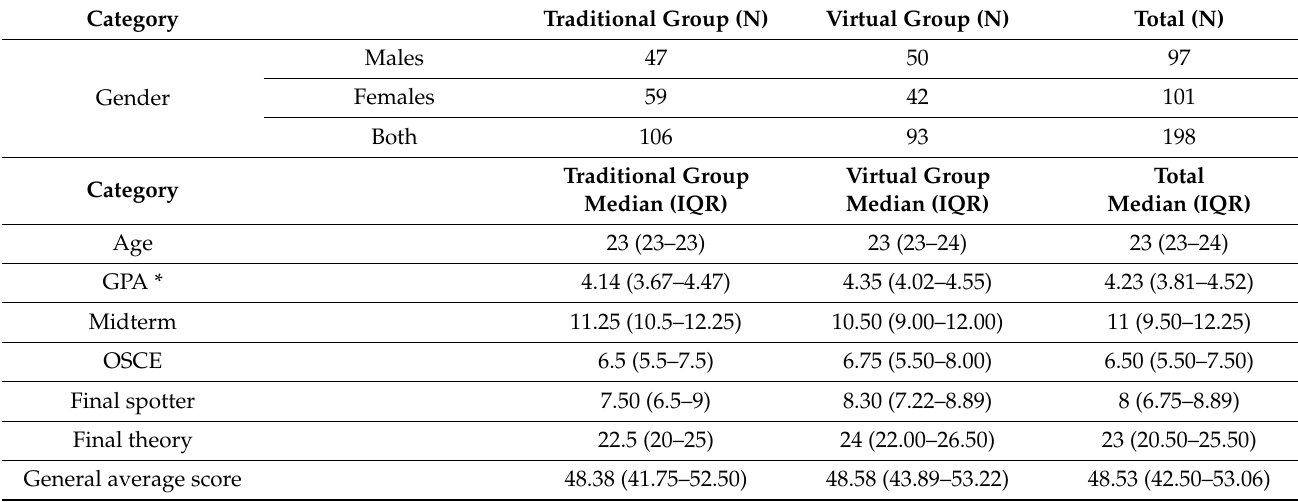
Table 2. Descriptive statistics of types of educational assessments in orthodontic